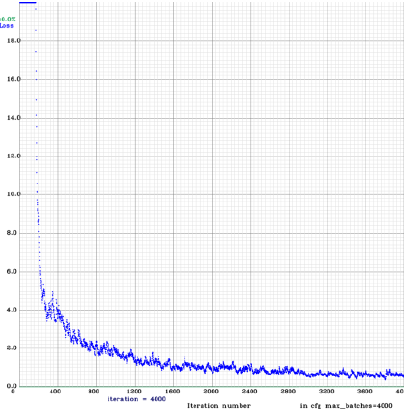
Figure 7 . The average loss function of the training.